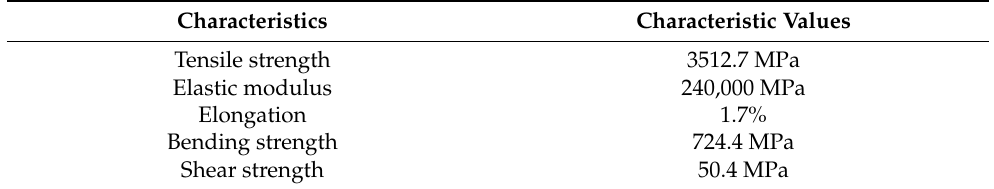
Table 2. Mechanical properties of the CFRP fabrics.